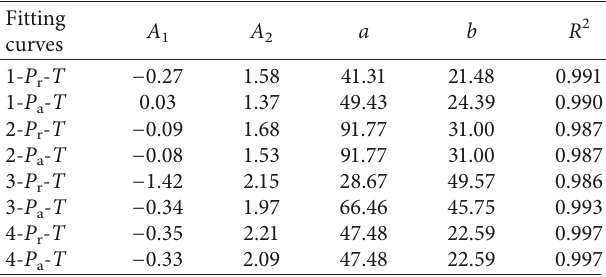
Table 2: Fitting parameters of the fitting